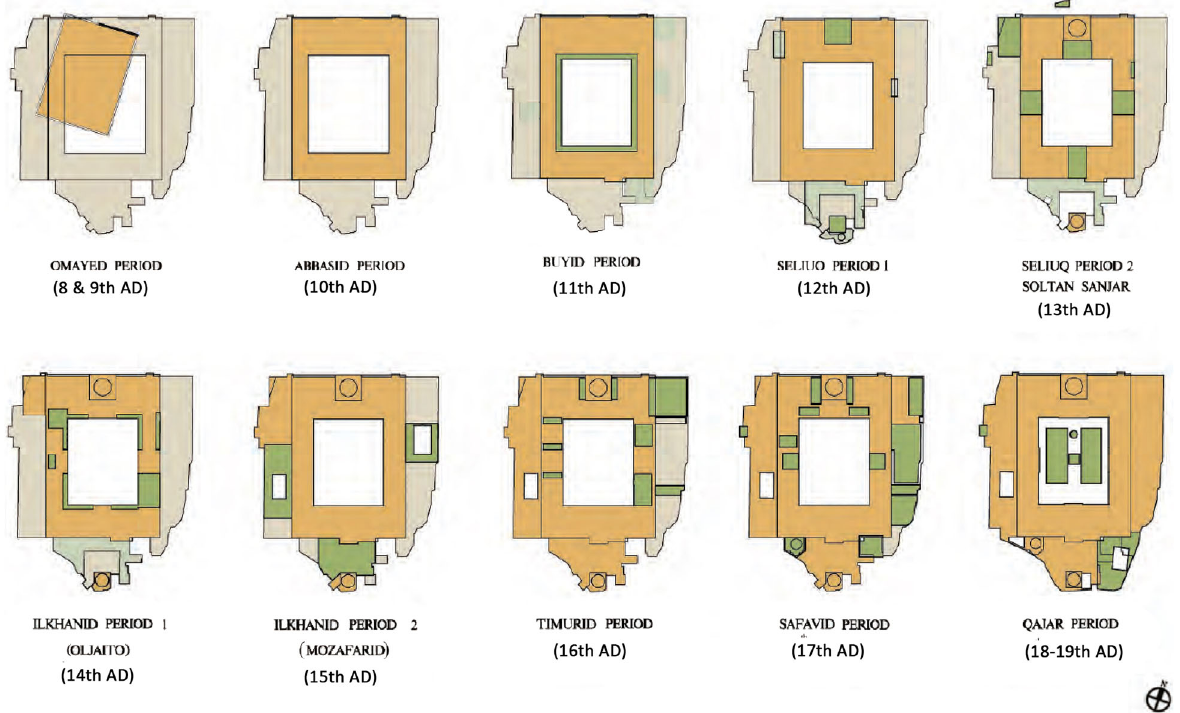
Fig. 5 Historical changes in the Masjed-e J ā me ʿ of Isfahan between the 8th and 19th centuries (Source: ICHHTO 2011, 186)